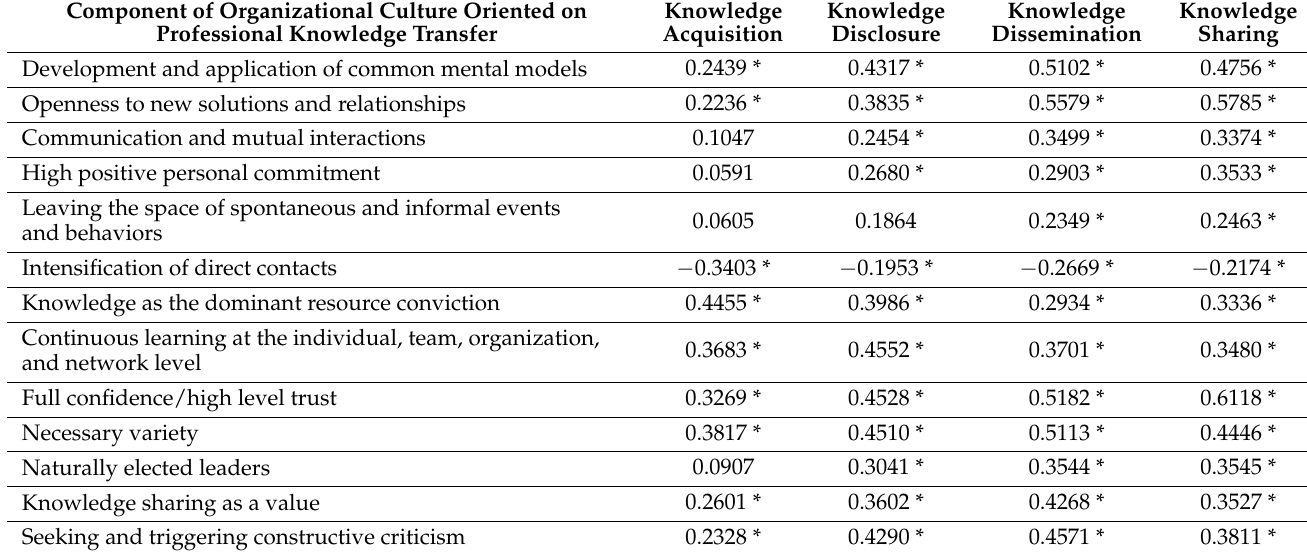
Table 5. Pearson’s correlation coefficient matrix for the variables of organizational culture oriented on professional knowledge exchange and knowledge transfer